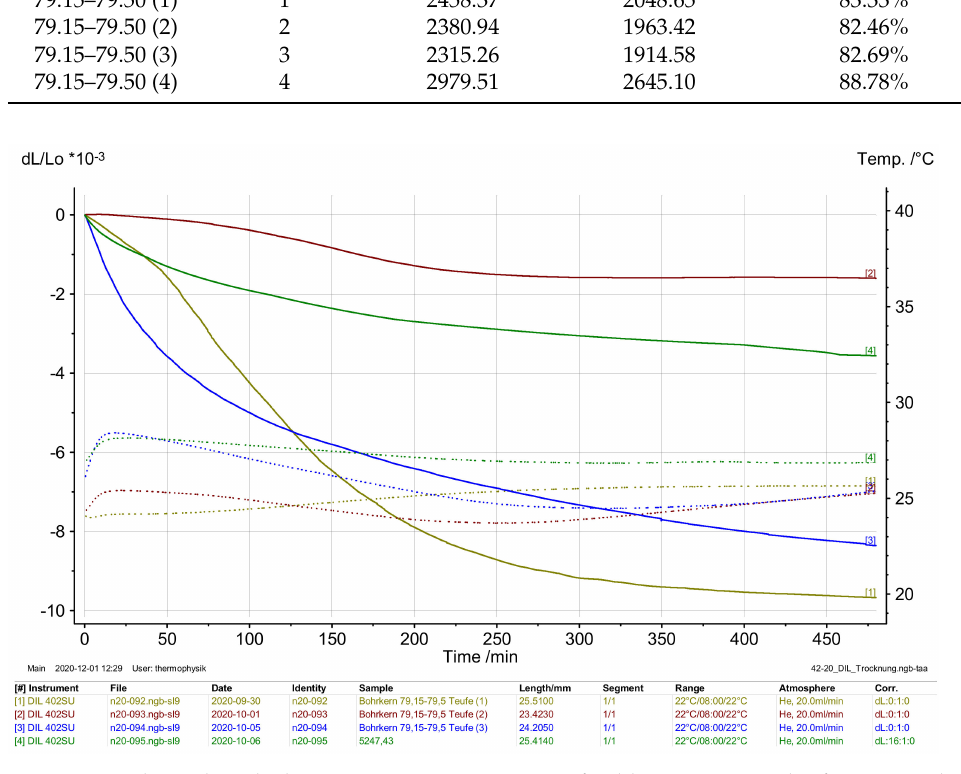
Figure 13. Relative length change at room temperature of 4 dilatometer samples from 79 m-depth drill cores in a moist